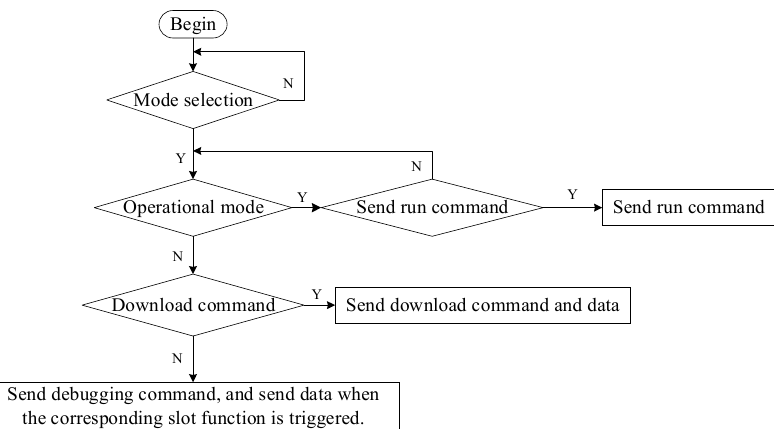
Figure 23. Software fl ow of the remote wireless debugging module.